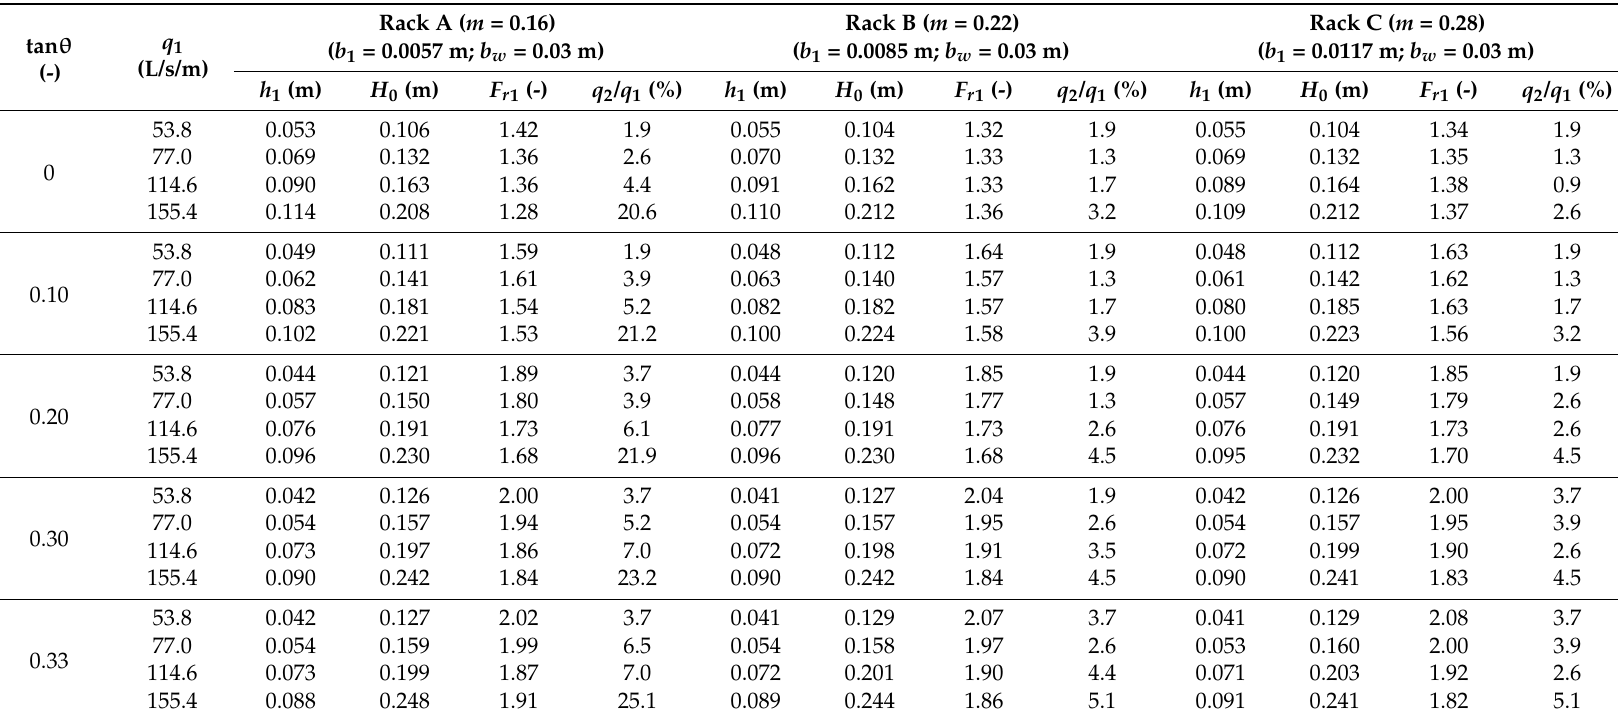
Table 2. Geometric characteristics of racks in the physical device and details of the